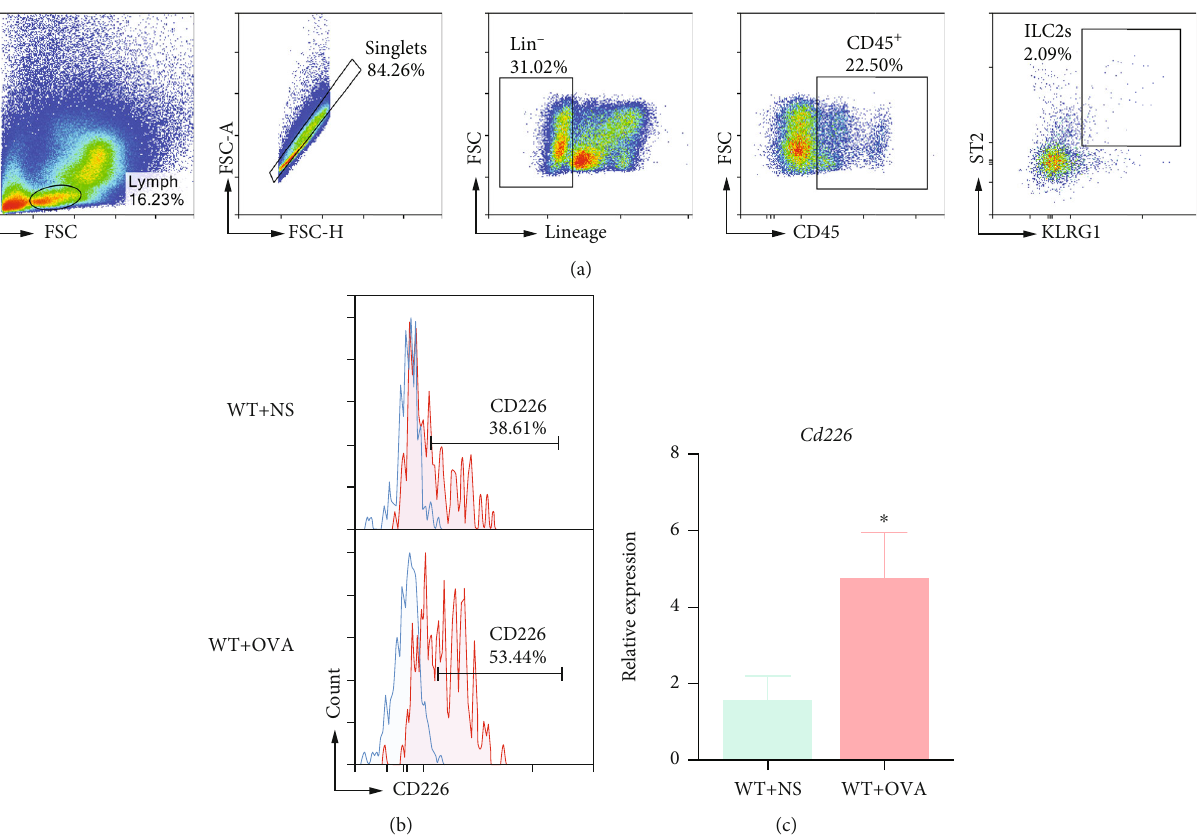
Figure 4: CD226 is inducible on nasal mucosal ILC2s. (a) Gating strategy for the identi fi cation of ILC2s (Lin − CD45 + ST2 + KLRG1 + ). (b) CD226 expression on isolated ILC2s from the nasal mucosa of control and AR mice using FCM assay. (c) CD226 expression in the nasal mucosa of control and AR mice using qPCR assay ( n = 4 ). The mice were sensitized against OVA and challenged with OVA at regular intervals; the control mice were sensitized and challenged with only saline. AR: allergic rhinitis; OVA: ovalbumin; NS: normal saline; ILC2s: type 2 innate lymphoid cells; FCM: fl ow cytometry; qPCR: quantitative real-time PCR; WT: wild type; KO: knockout; ∗ P < 0 : 05